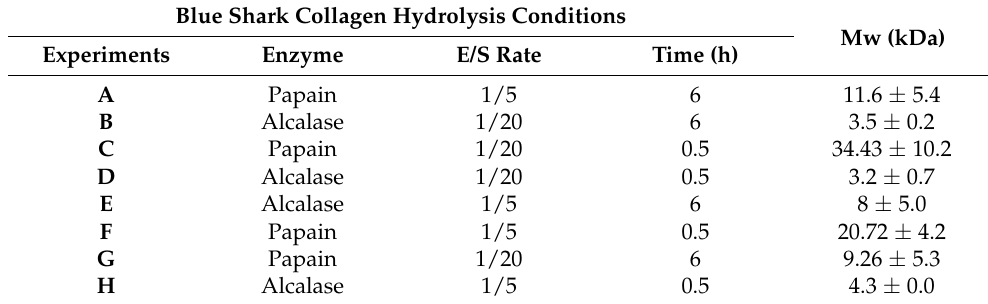
Table 2. Mw (Mean ± SD) obtained after GPC-LS analysis of BSCH prepared in different conditions (enzyme: Alcalase or Papain; time of hydrolysis: 30 min or 6 h; E/S ratio: 1/5 or 1/20). Values are resultant of three GPC-LS determinations per hydrolysis condition.